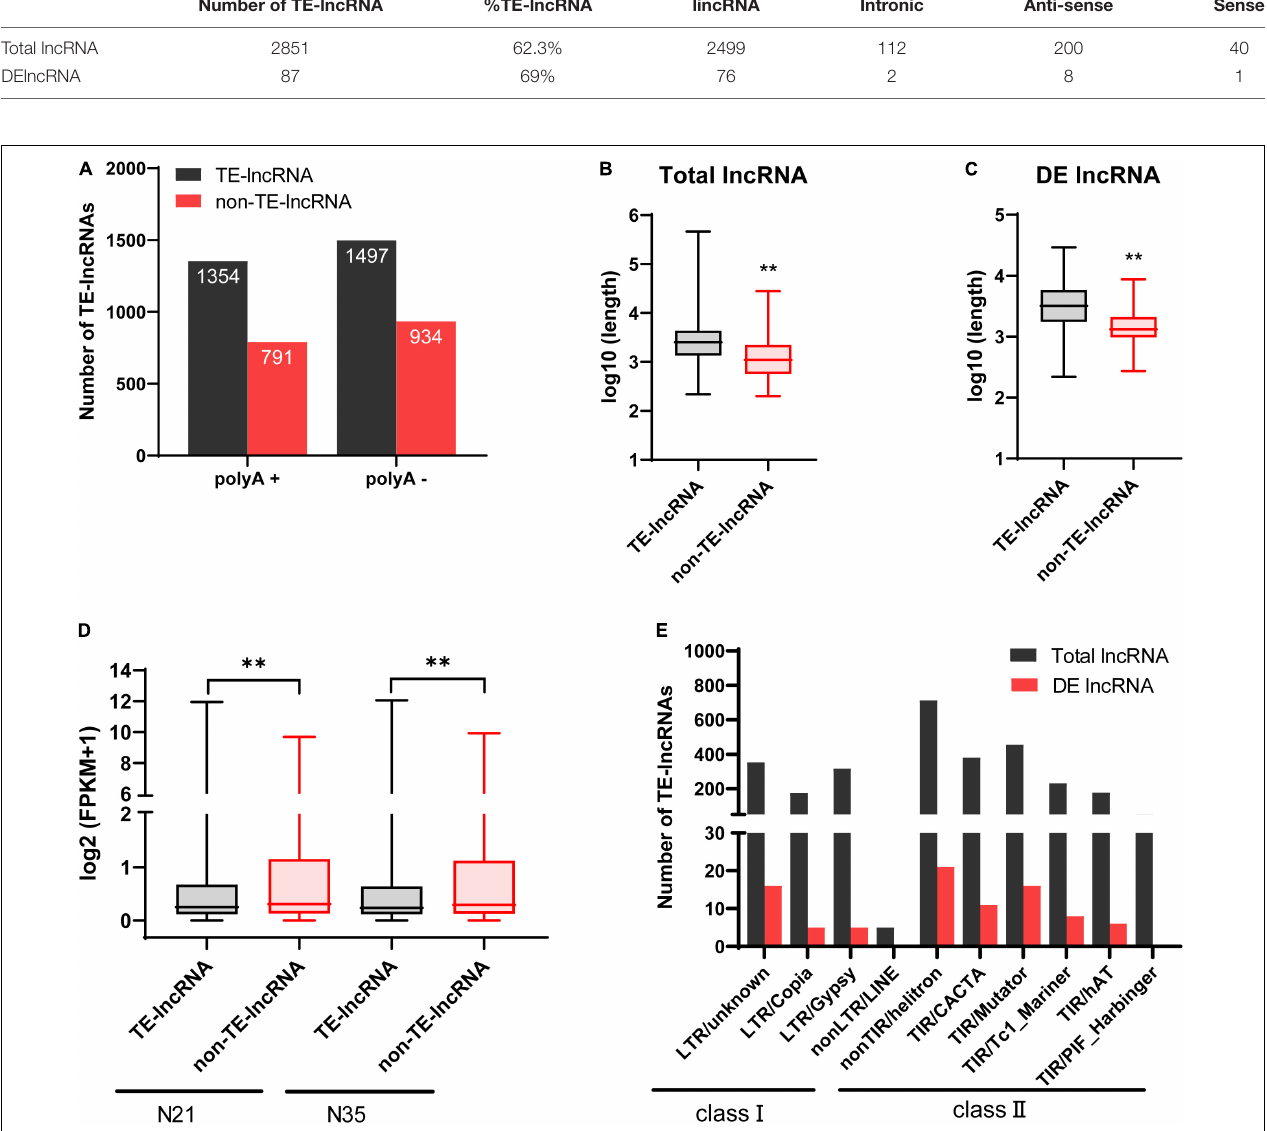
FIGURE 5 | Characterizations of TE-lncRNAs. (A) The numbers of TE- and non-TE-lncRNAs in polyA+ and polyA-. (B) Average length of TE- and non-TE-lncRNAs in total lncRNAs. (C) Average length of TE- and non-TE-lncRNAs in DElncRNAs. (D) The expression levels (FPKM) of TE- and non-TE-lncRNAs. (E) Different TE families associated with total lncRNAs and DElncRNAs. ∗∗ p < 0.01(Wilcoxon test).